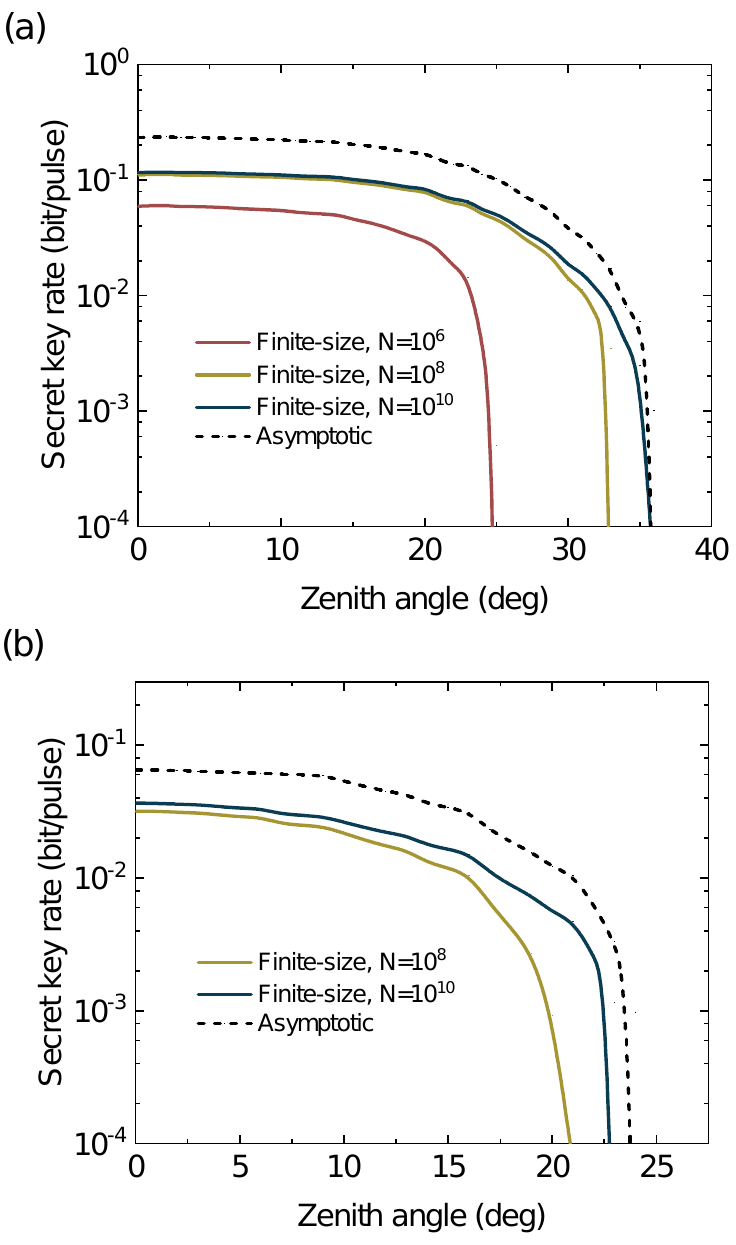
Figure 8. Secret key rate vs. zenith angle with finite-size effect for the satellite altitudes: ( a ) H = 100 km; ( b ) H = 120